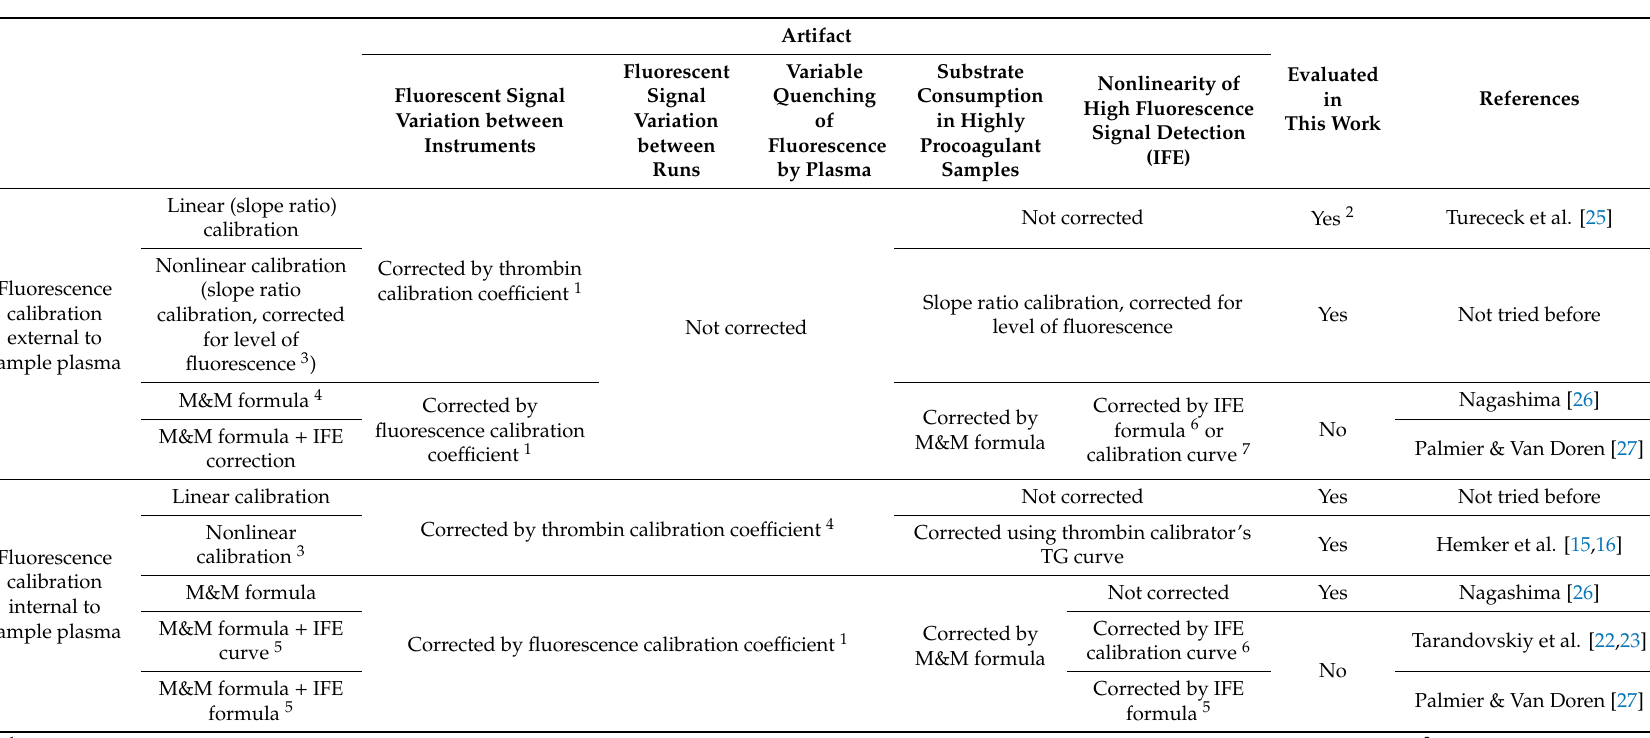
Table 2. Internal and external algorithms used for fluorescence calibration and artifact correction of TG data. Note that a mathematical algorithm of subtracting background T- α 2MG activity from the calibrated and corrected TG curve is not shown here